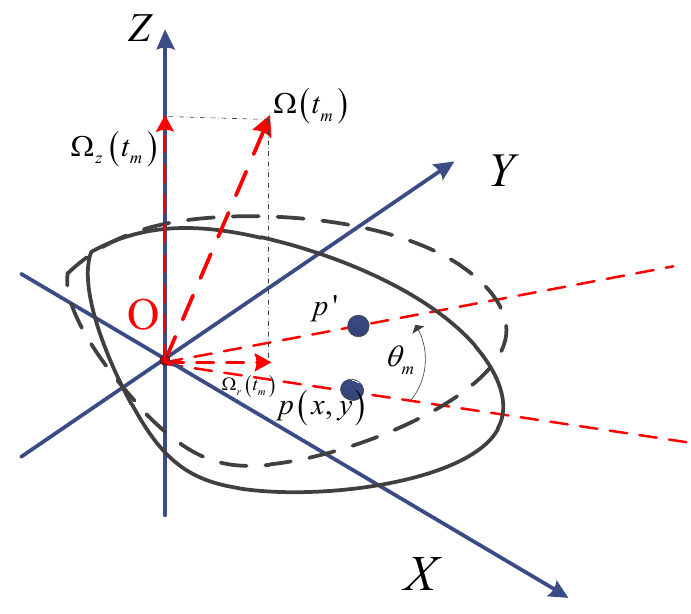
Figure 1. The geometry of a rotating target.